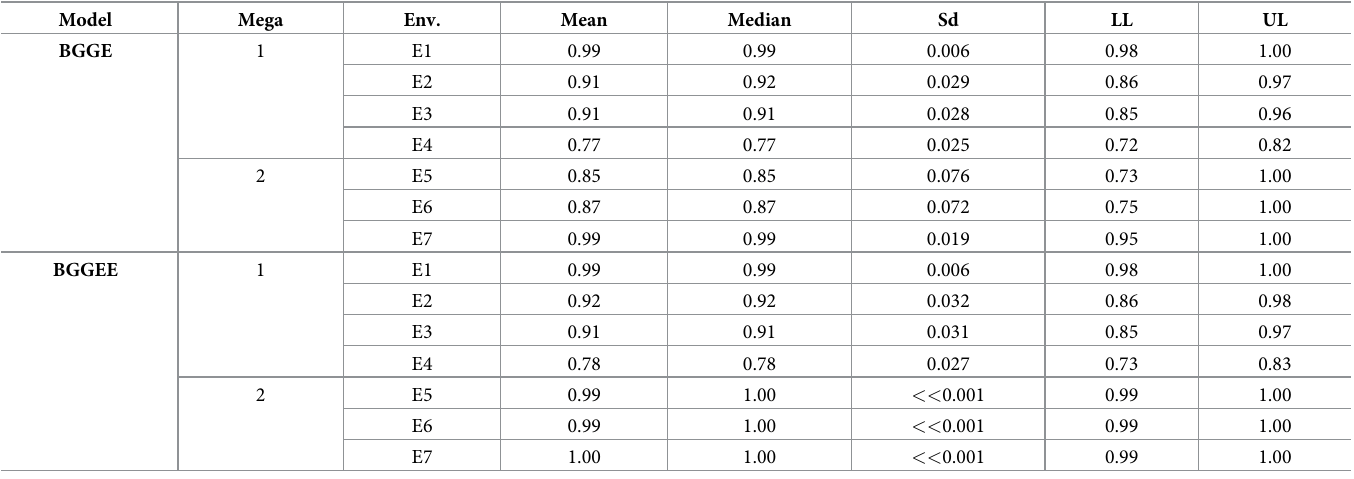
BGGE, Bayesian-GGE; BGGEE, Bayesian-GGE entropy; Sd, standard deviation; LL, lower limit; UL, upper limit; Env., environment; Mega, mega-environments; A << B implies A <